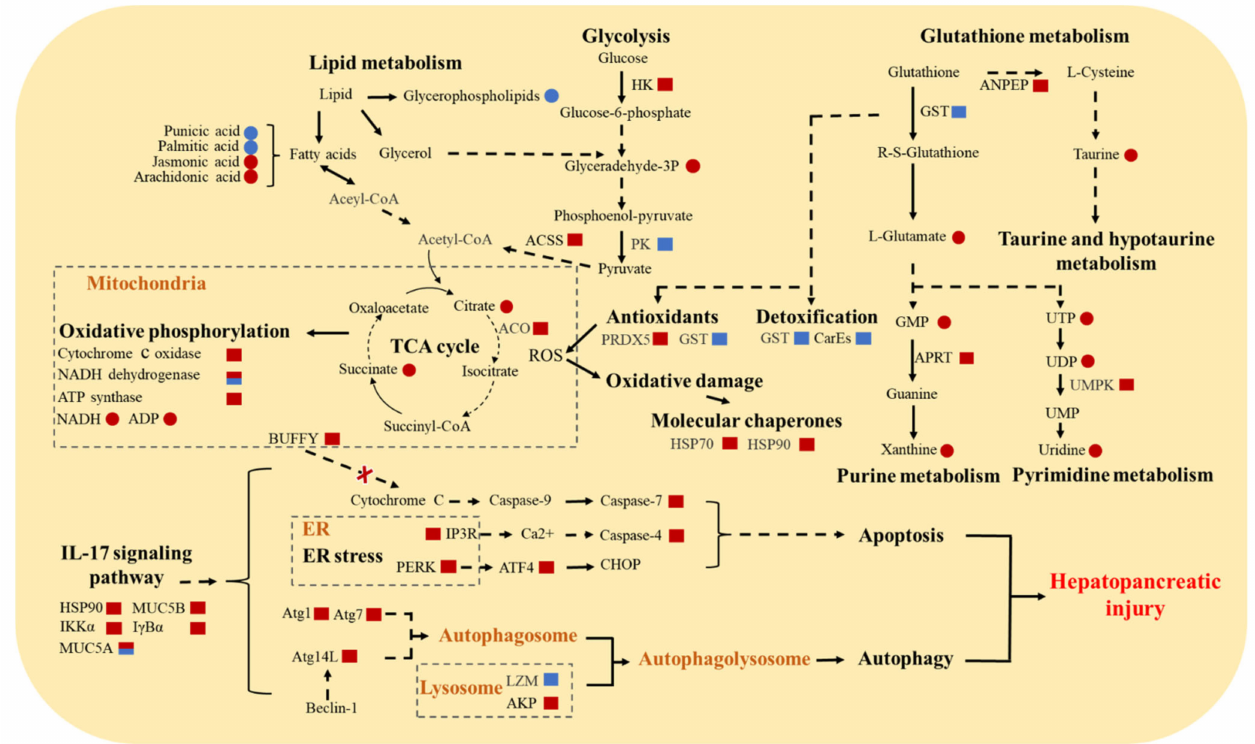
Figure 7. Hypothetical pathways for metabolome and transcriptome changes in E. sinensis with HPND. The boxes represent genes, and the dots represent metabolites. Red and blue represent up- and down-regulation, respectively, and both red and blue represents both up- and down-regulation. The solid arrows and dashed arrows indicate direct and indirect effects. Arrows with × indicate inhibition. PK: pyruvate kinase; ACSS: acetyl-CoA synthetase; ACO: aconitate hydratase; HK: hexokinase; UMPK: UMP-CMP kinase; APRT: adenine phosphoribosyltransferase; ANPEP: aminopeptidase